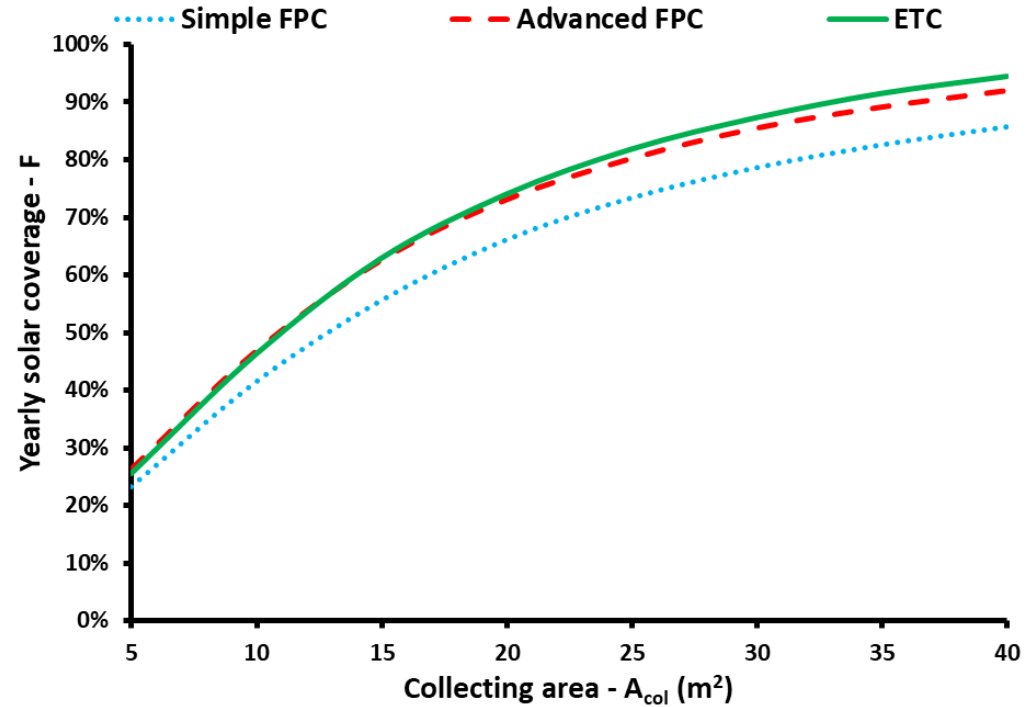
Figure 8. Yearly solar coverage with optimum tilt angles for the location of Athens.